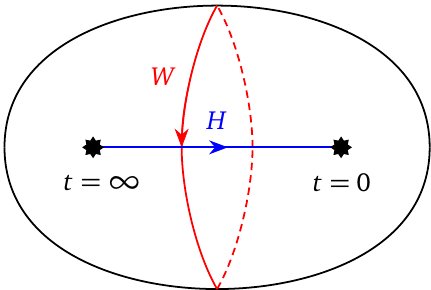
Figure 7: The Wilson ( W , red) and ’t Hooft ( H , blue) lines in the Class S realization of the 4d N = 2 su ( 2 ) pure SYM